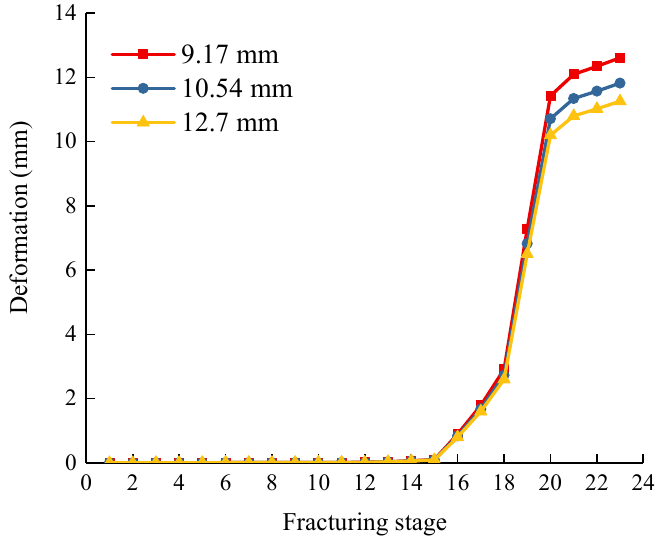
Figure 13. Effect of casing thickness on casing deformation.